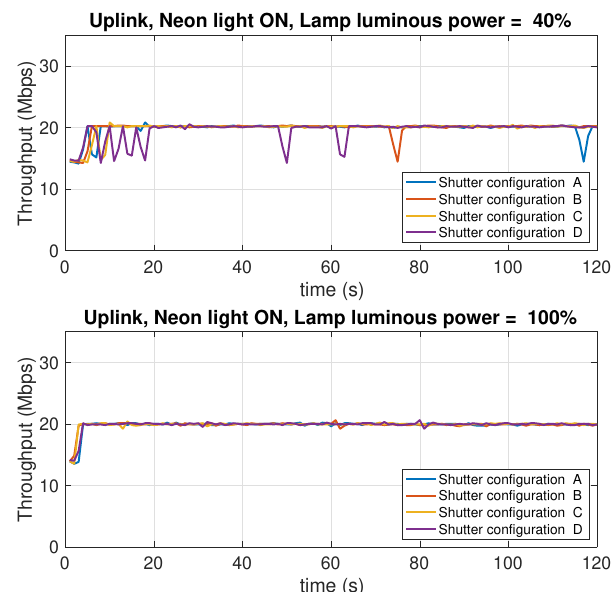
Figure 23. Uplink throughput with different shutter configurations (see Table 1). Neon lights ON. LED lamp luminous power: 40% (top charts) and 100% (bottom charts) of the maximum value of 1930lm.